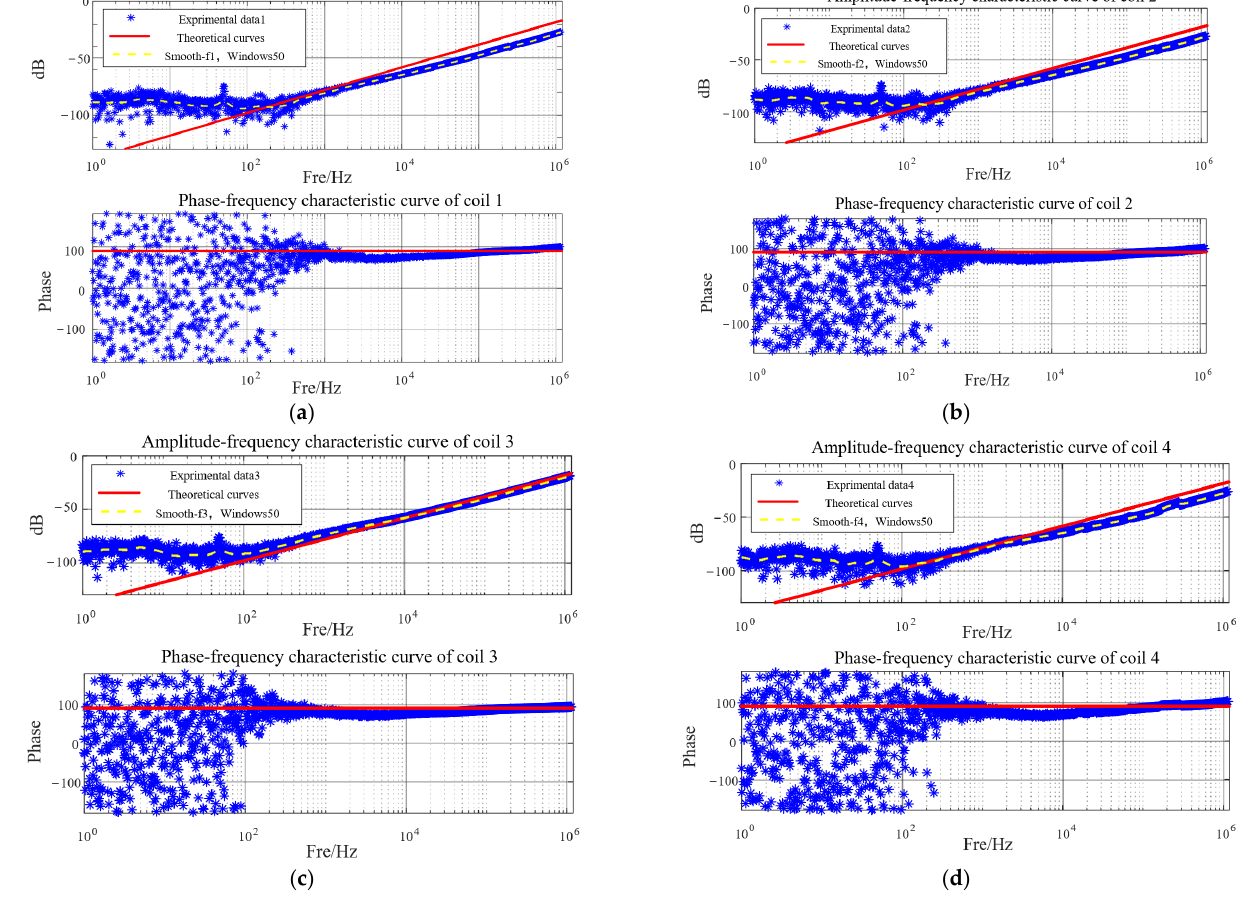
Figure 12. Bode diagram of coils 1–4 ( a ) Coil 1. ( b ) Coil 2. ( c ) Coil 3. ( d ) Coil 4.